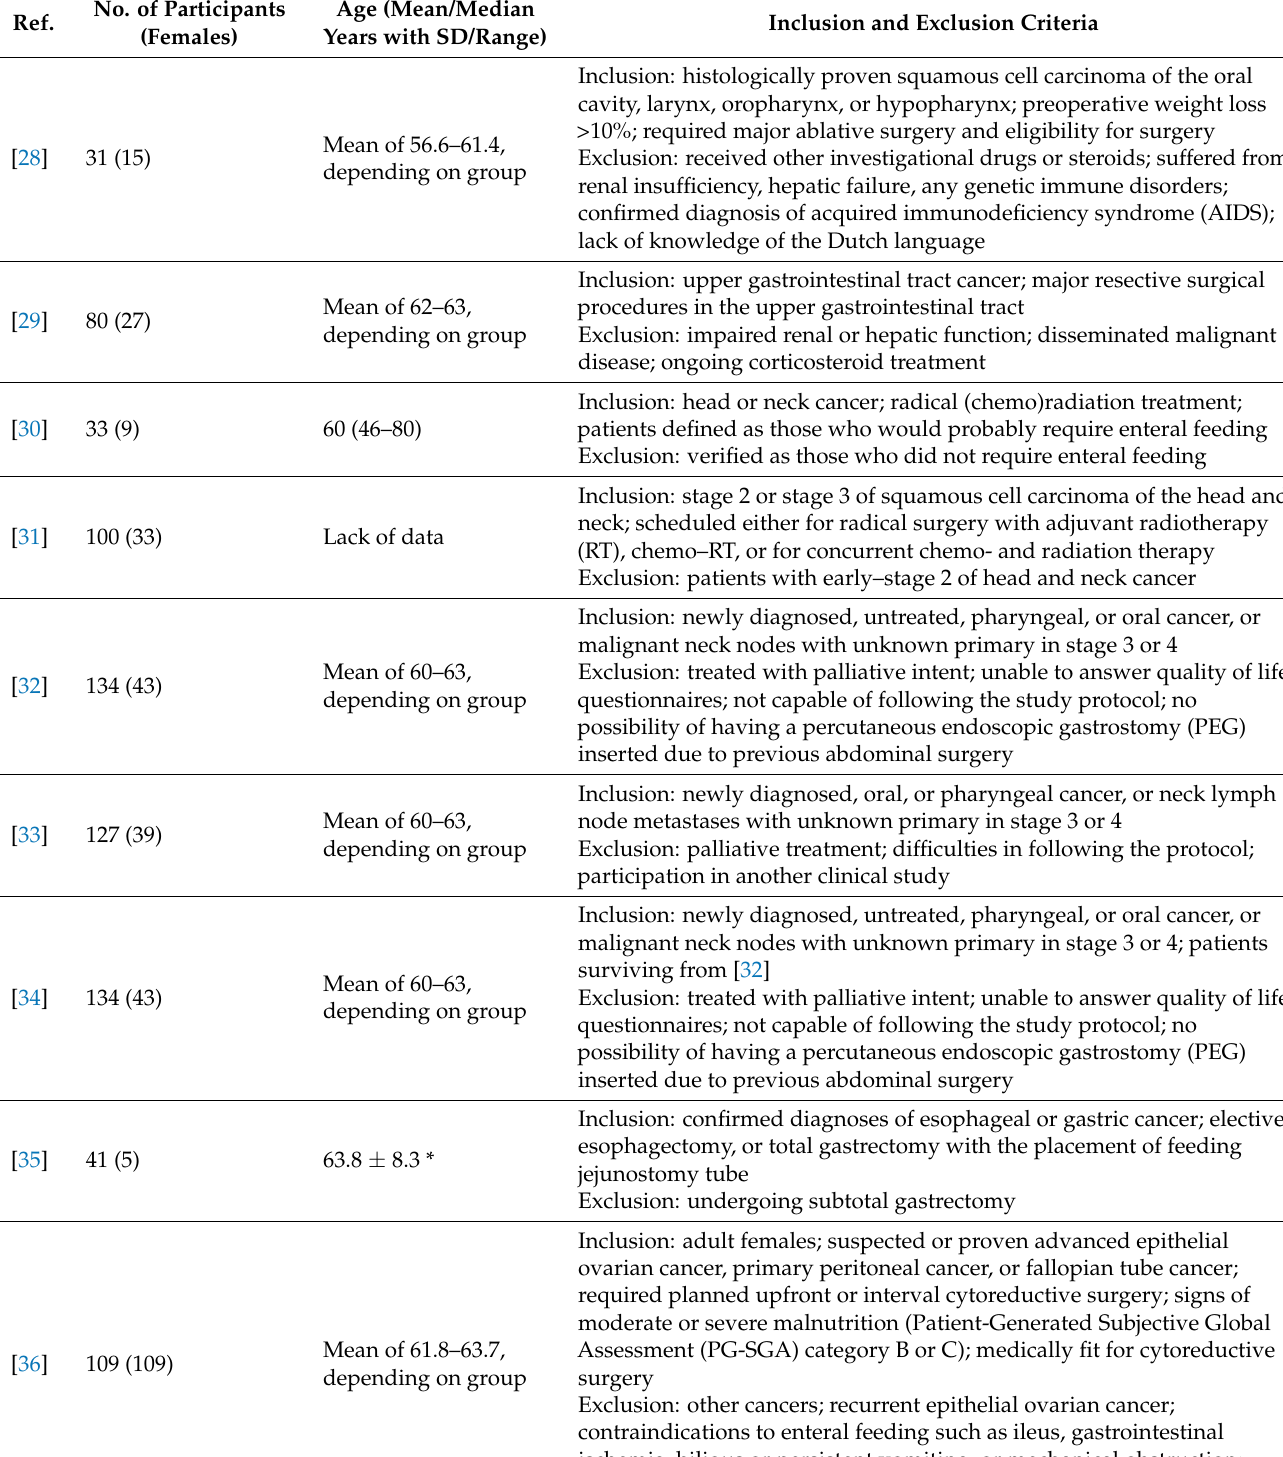
Table 5. The basic characteristics of the groups studied within the studies included in the systematic review.